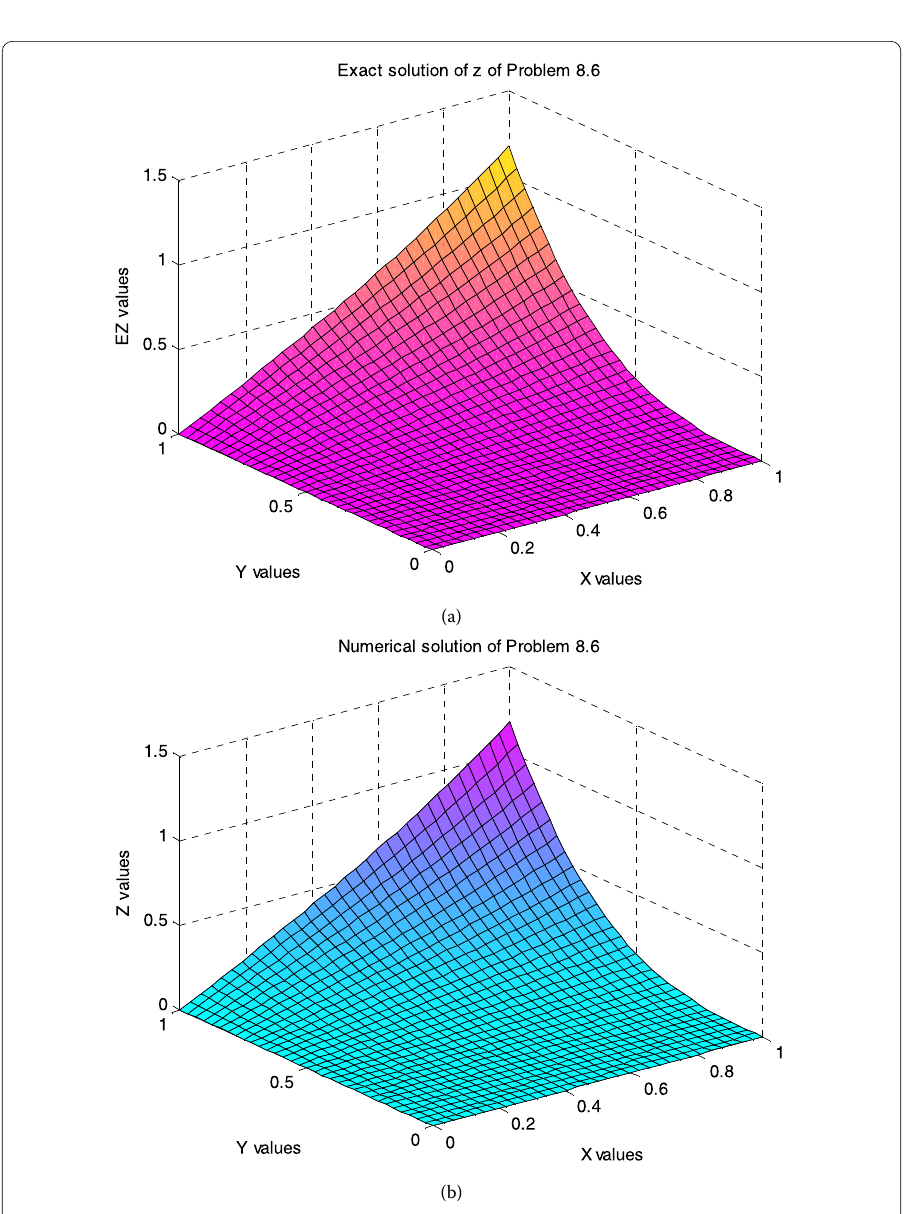
Figure 7 ( a ) Exact solution of Problem 8.6 for z ( x , y ) for h = 1/32 and Re = 10. ( b ) Numerical solution of Problem 8.6 for z ( x , y ) for h = 1/32 and Re = 10. ( c ) Exact solution of Problem 8.6 for v ( x , y ) for h = 1/32 and Re = 10. ( d ) Numerical solution of Problem 8.6 for v ( x , y ) for h = 1/32 and Re =